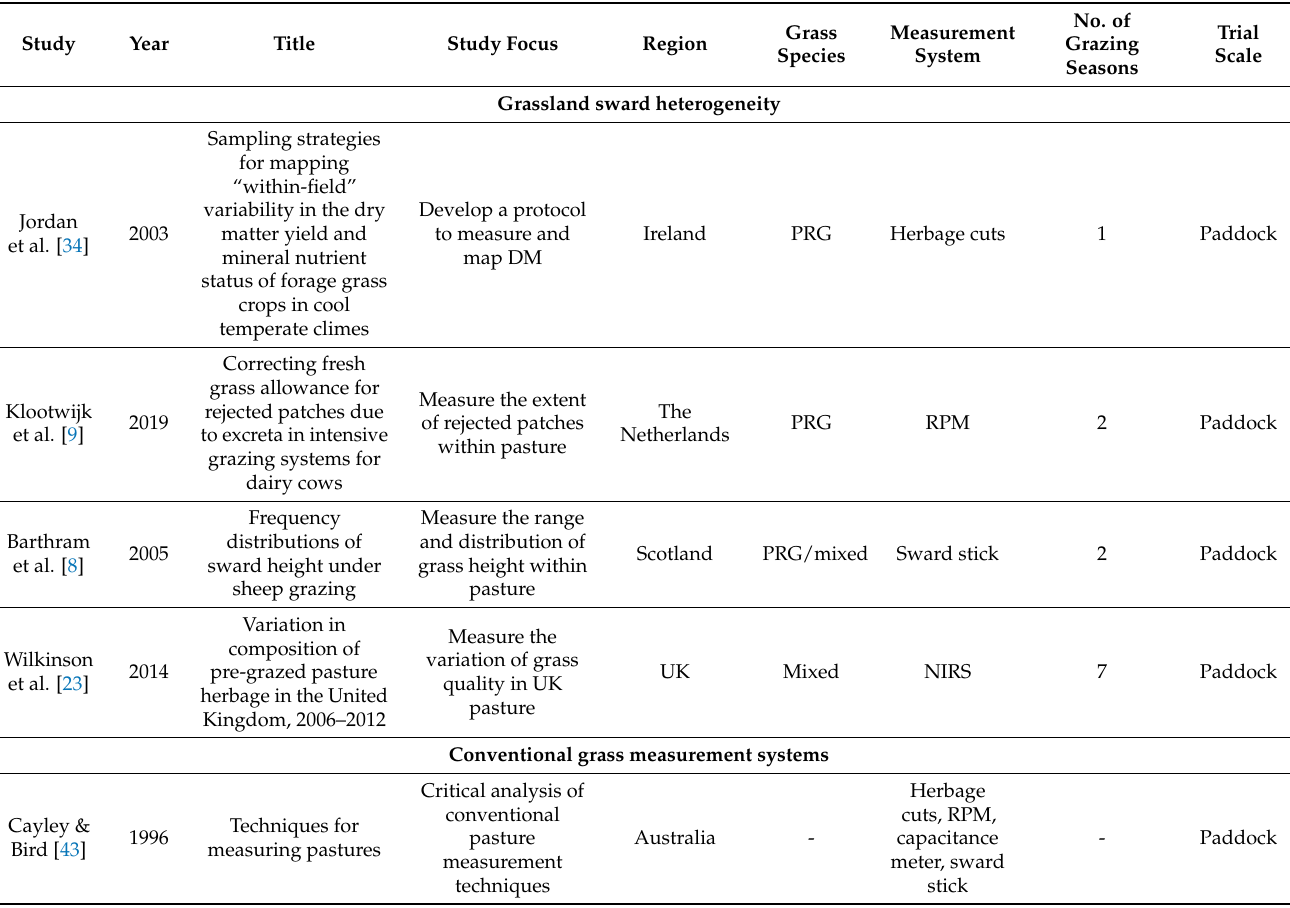
Table A1. Summary of literature review dataset of studies relevant to grass measurement on temperate (Irish)